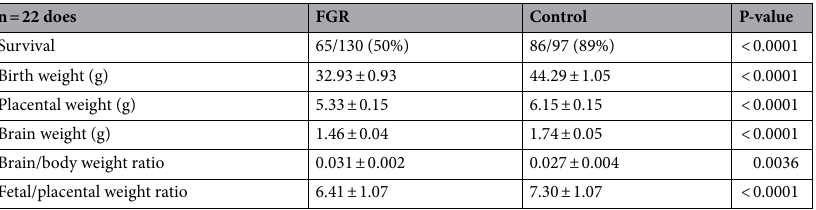
Table 1. Survival and biometrics. Survival and birth weight were assessed 4 h after caesarian delivery. Brain weight was measured at PND1. Data were analysed with Fischer’s exact test or using a linear mixed-effects model. Values are displayed as mean ± SE. FGR: fetal growth